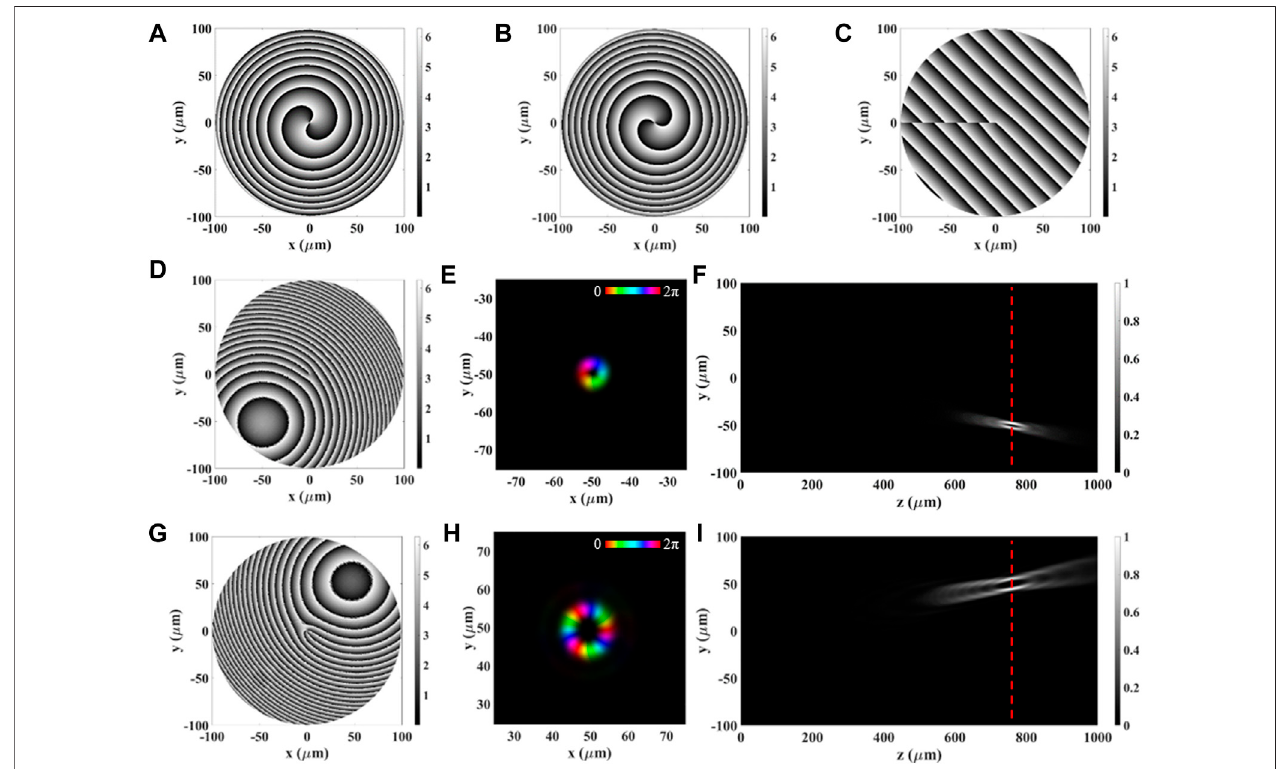
FIGURE 6 | Simulations of DFML implementing Eqs 18 , 19 . (A – C) ML design phase maps of δ x (A) , δ y (B) , and θ (C) from Eqs 7 – 9 . (D,G) show ϕ + and ϕ − phase maps, respectively. (E) Intensity and phase of the propagated fi eld under LCP polarization at z (cid:2) 750µm. (F) Intensity cross-section ( yz -plane, from 0 to 1 mm, x = − 50 µm) under LCP polarization. (H) Intensity and phase of the propagated fi eld under RCP polarization at z (cid:2) 750µm. (I) Intensity cross-section ( yz -plane from 0 to 1 mm , x = +50 µm) under RCP polarization. In (E,H) , brightness and colours refer to intensity and phase, respectively.